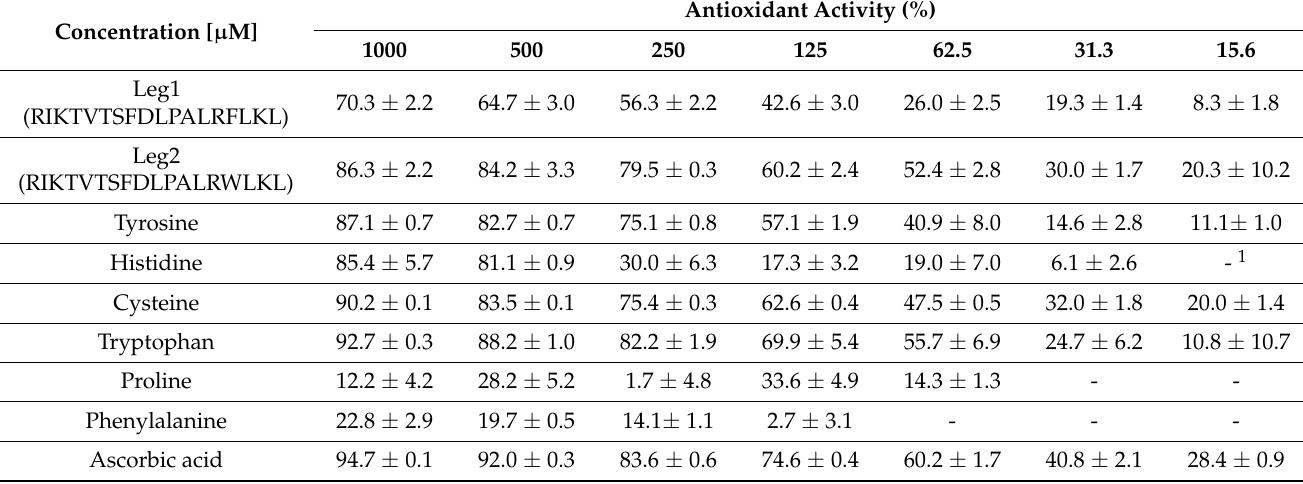
Table 4. Results of the reducing power assay using Leg1/Leg2 and single amino acids in a concentration range of 15.6–1000 µ M. Ascorbic acid was used as the positive control. The mean ± SD of triplicates of the antioxidative activity is